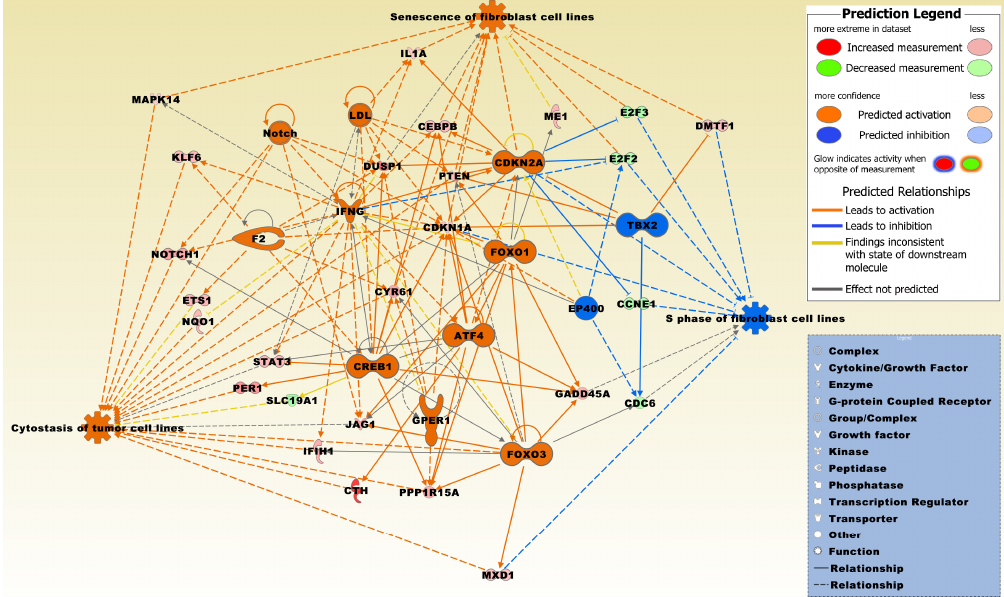
Figure 3. The regulator effects network had a consistency score of 7.3 and was significantly related to the microarray expression profiles of the 830 DEG set. Regulators include activating transcription factor 4 (ATF4), cyclin dependent kinase inhibitor 2A (CDKN2A), cAMP responsive element binding protein 1 (CREB1), E1A binding protein p400 (EP400), coagulation factor II, thrombin (F2), forkhead box O3 (FOXO3), G protein-coupled estrogen receptor 1 (GPER1), interferon gamma (IFNG), low density lipoprotein (LDL), notch receptor (Notch), and T-box 2 (TBX2). Molecules from the 830 DEG set involved in the network include CCNE1, CDC6, CDKN1A, CEBPB, CTH, CYR61, DMTF1, DUSP1, E2F2, E2F3, ETS1, FOXO1, GADD45A, IFIH1, IL1A, JAG1, KLF6, MAPK14, ME1, MXD1, NOTCH1, NQO1, PER1, PPP1R15A, PTEN, SLC19A1, and STAT3. The network was overlaid with the molecule activity predictor to calculate further molecular effects, as outlined in the prediction legend. The two functions, cytostasis of tumor cell lines and senescence of fibroblast cell lines, were predominantly activated whereas the function, S phase of fibroblast cell lines, was predominantly inhibited.